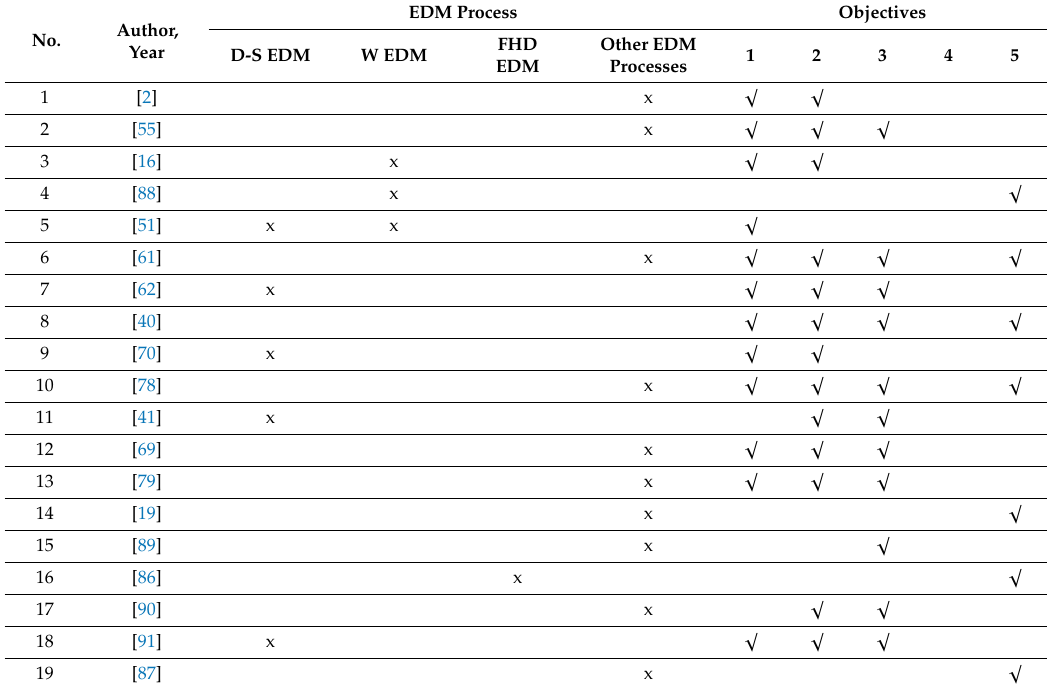
Table 4. List of the studies for di ff erent powder-mixed dielectric in various EDM processes.